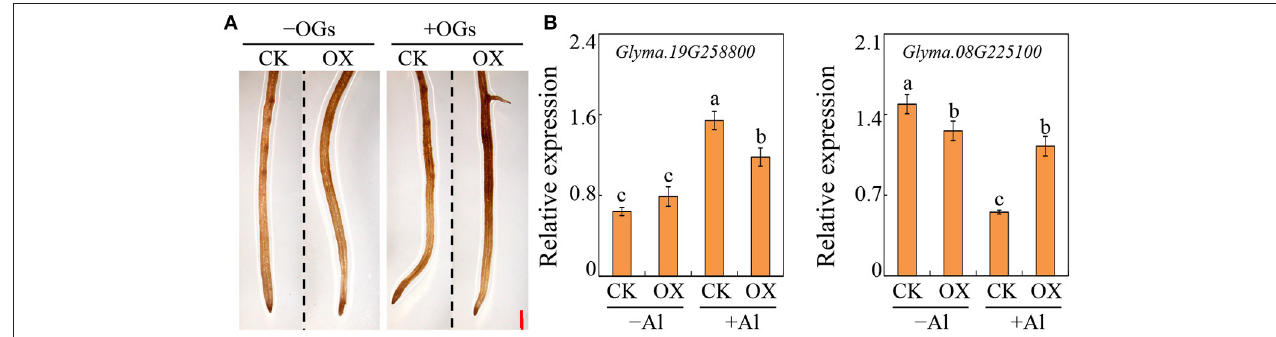
FIGURE 6 | Effects of GmBBE-like43 overexpression on root surface H 2 O 2 generation and the expression of two Al-regulated auxin-response genes. (A) DAB staining of transgenic soybean hairy roots expressing either 35S::GmBBE-like43 (OX) or empty vector (CK) in treatments with or without OGs; (B) Expression of auxin-responsive gene Glyma.19G258800 and Glyma.08G225100 in transgenic soybean hairy roots in response to Al treatment. Values are means ± SE of four replicates. Different letters on the bar indicate differences among treatments ( P <